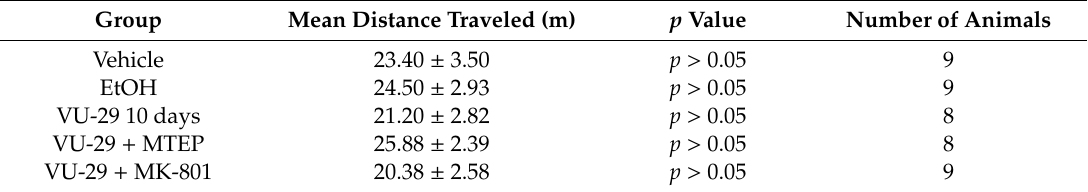
Table 7. The influence of MK-801 and MTEP on the e ff ect of VU-29 on the locomotor activity of rats recorded as distance (m) traveled in 15 min. Results are expressed as mean ±